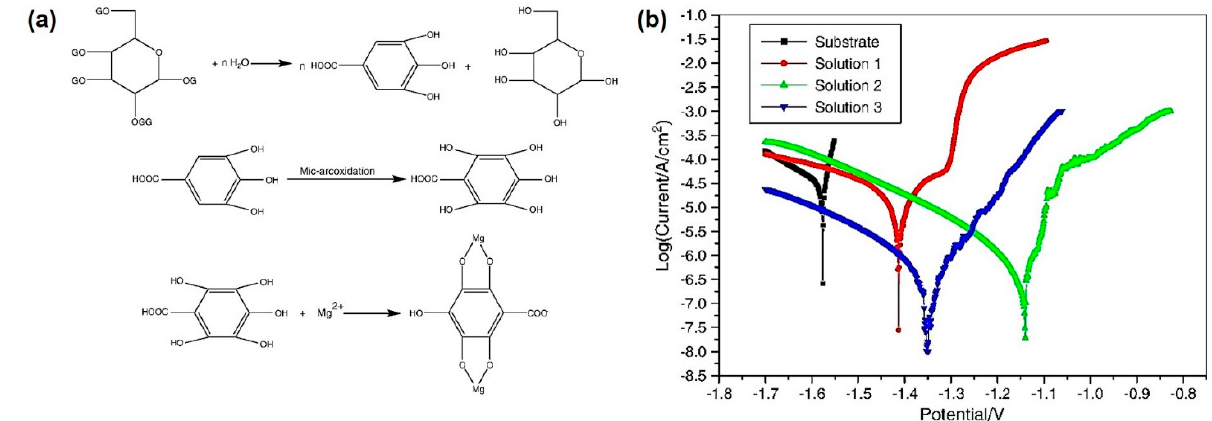
Figure 4. ( a ) The forming process of Mg alloy in tannic acid during PEO process. ( b ) potentiodynamic polarization (PDP) results for the coatings obtained in solutions 1, 2, and 3. Reprinted from permission from [66]. Copyright 2012 Elsevier.